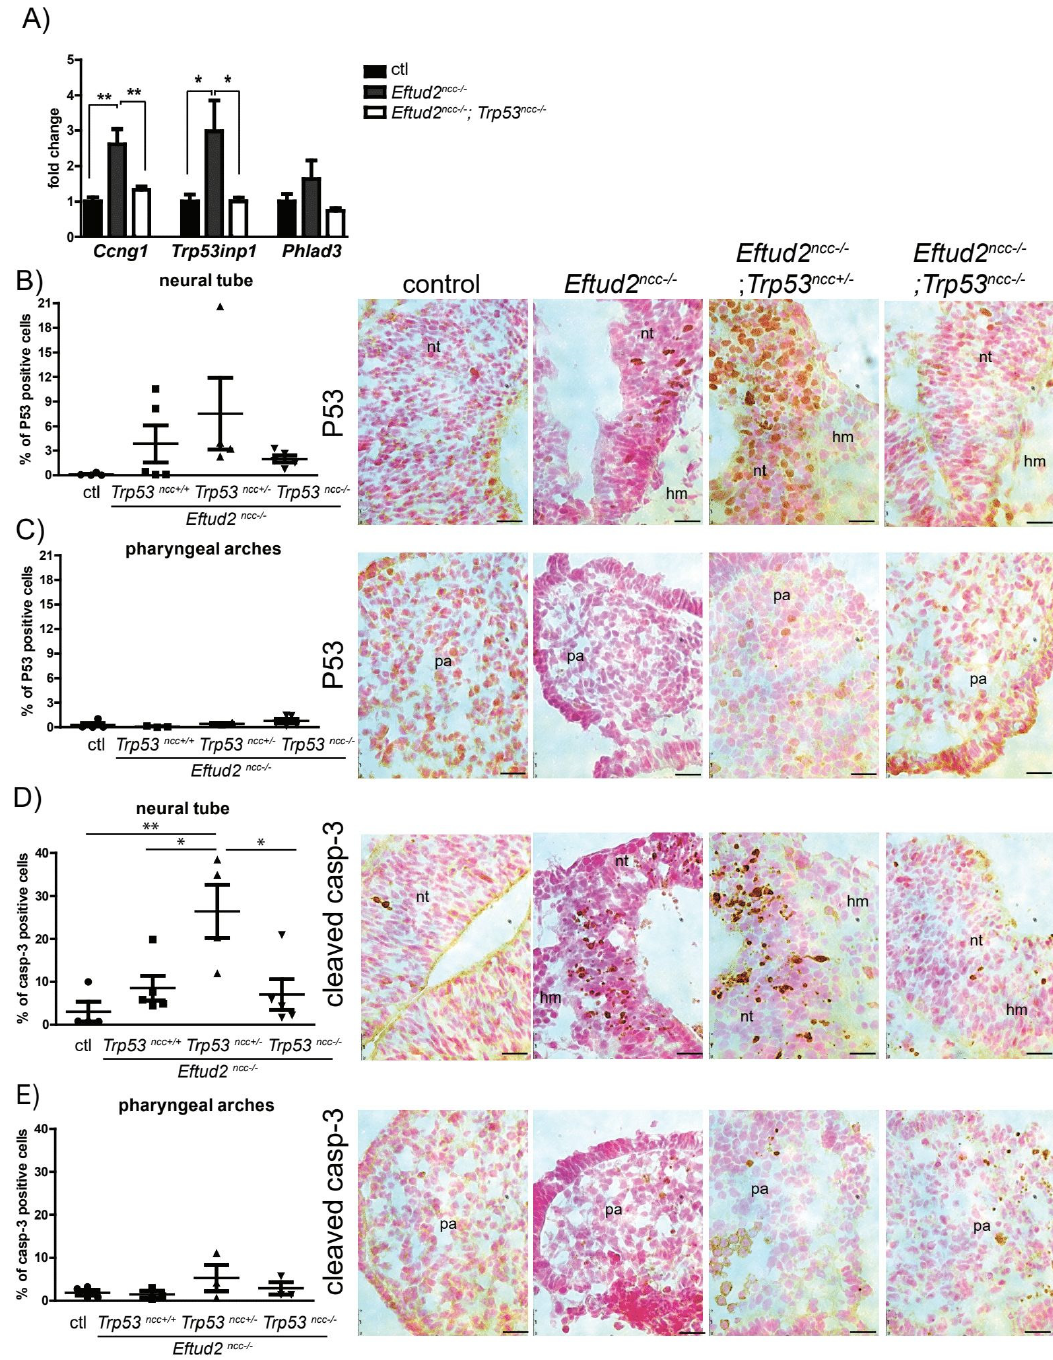
Figure 2. Eftud2 ncc − / − ; Trp53 ncc − / − embryos have decreased P53 activity and apoptosis at E10.5. ( A ) RT-qPCR analysis showed that levels of Ccng1 , Trp53inp1 and Phlda3 were significantly